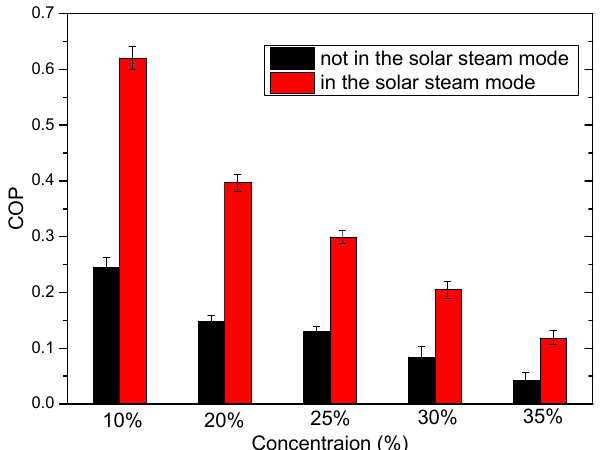
Figure 16. COP of the absorption system with LiCl solution as the absorbent in different modes.